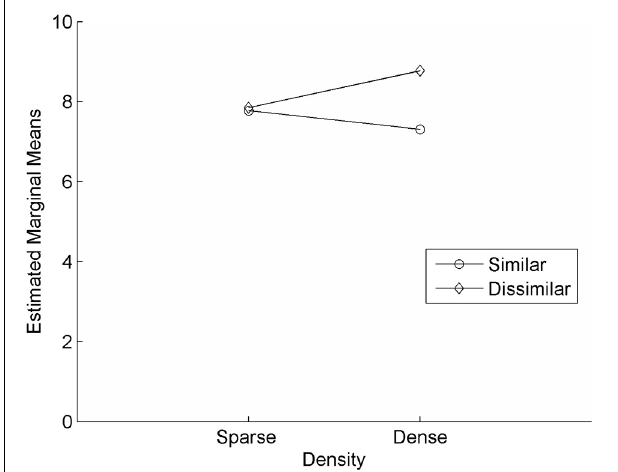
FIGURE 3 | Performance on the deletion portion of the task. (A–D) On all combinations of stimuli on the deletion task, the DYX group scored significantly lower than the TD group. There were no significant differences between the SLI group and the TD